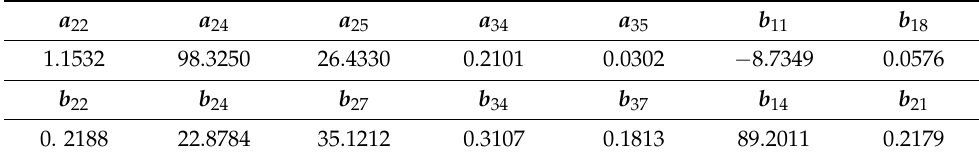
Table 2. Dynamic coefficient values of UAV.